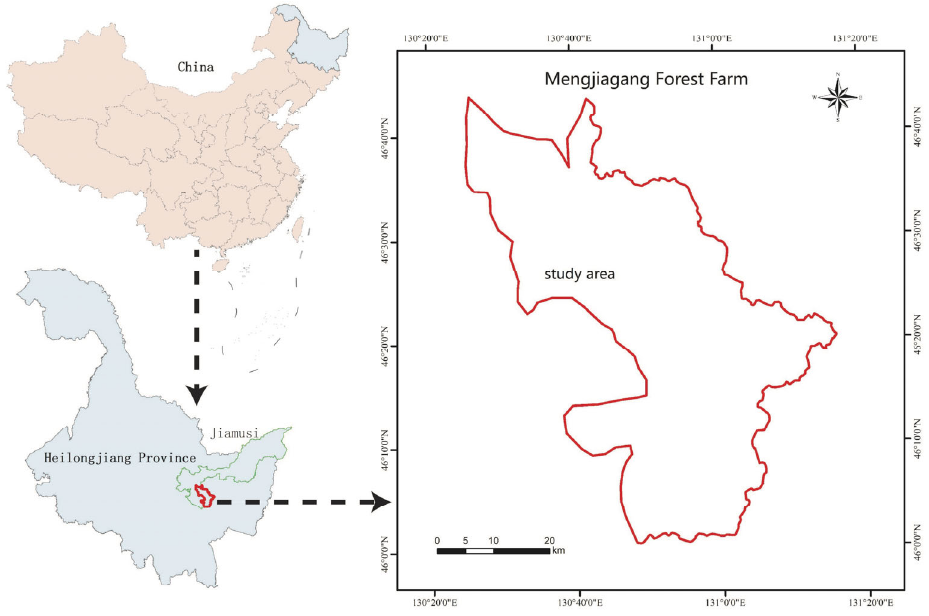
Figure 1. Location of the study area. Table 1. Basic characteristics of pure larch plantation and mixed larch–ash plantation.